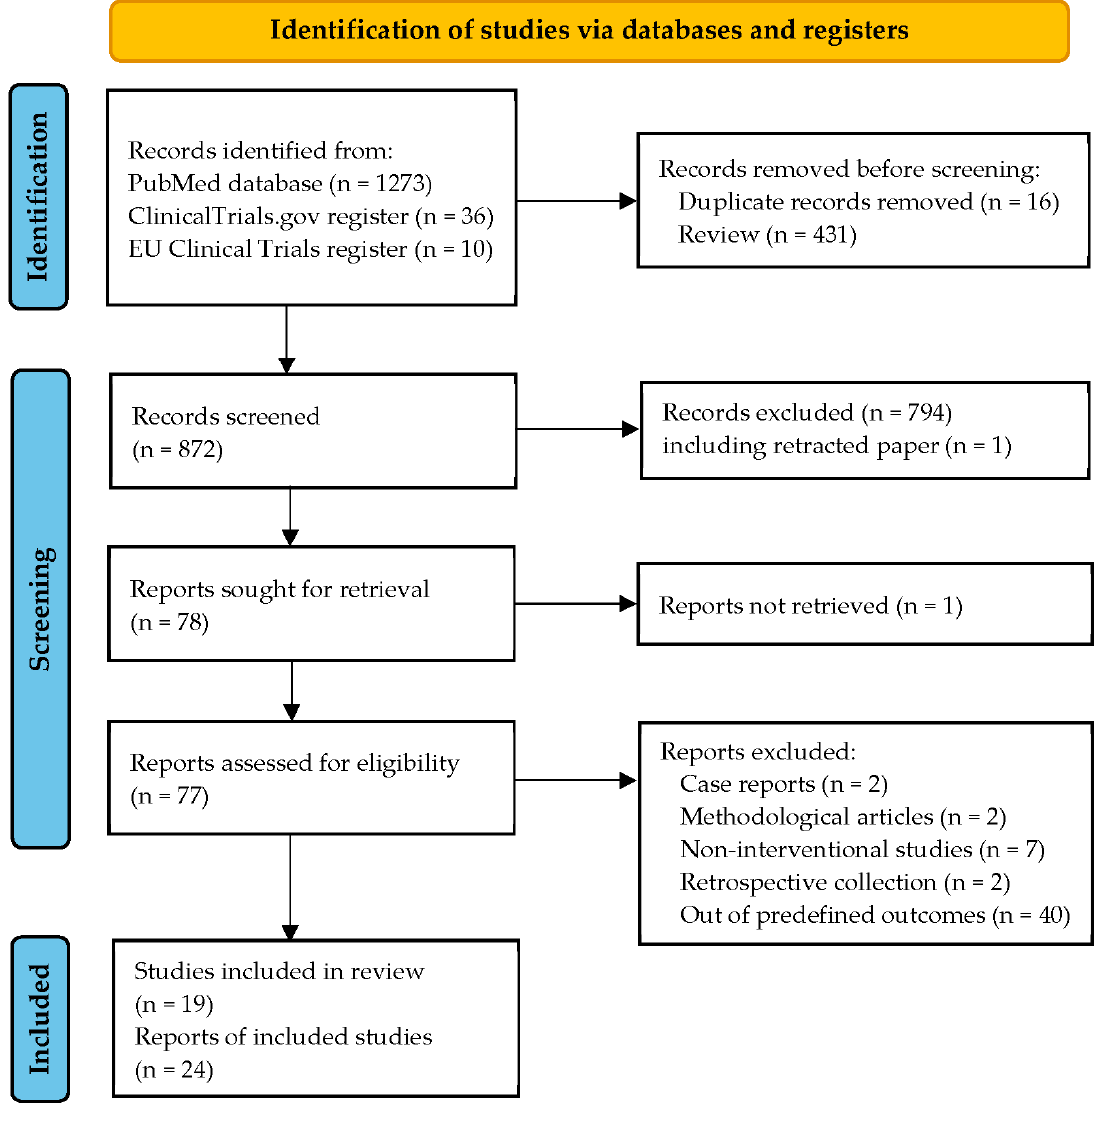
Figure 2. PRISMA 2020 flow diagram for the selection of records and studies. Table 2. Characteristics of selected studies. Sub-studies are grouped with the main study.